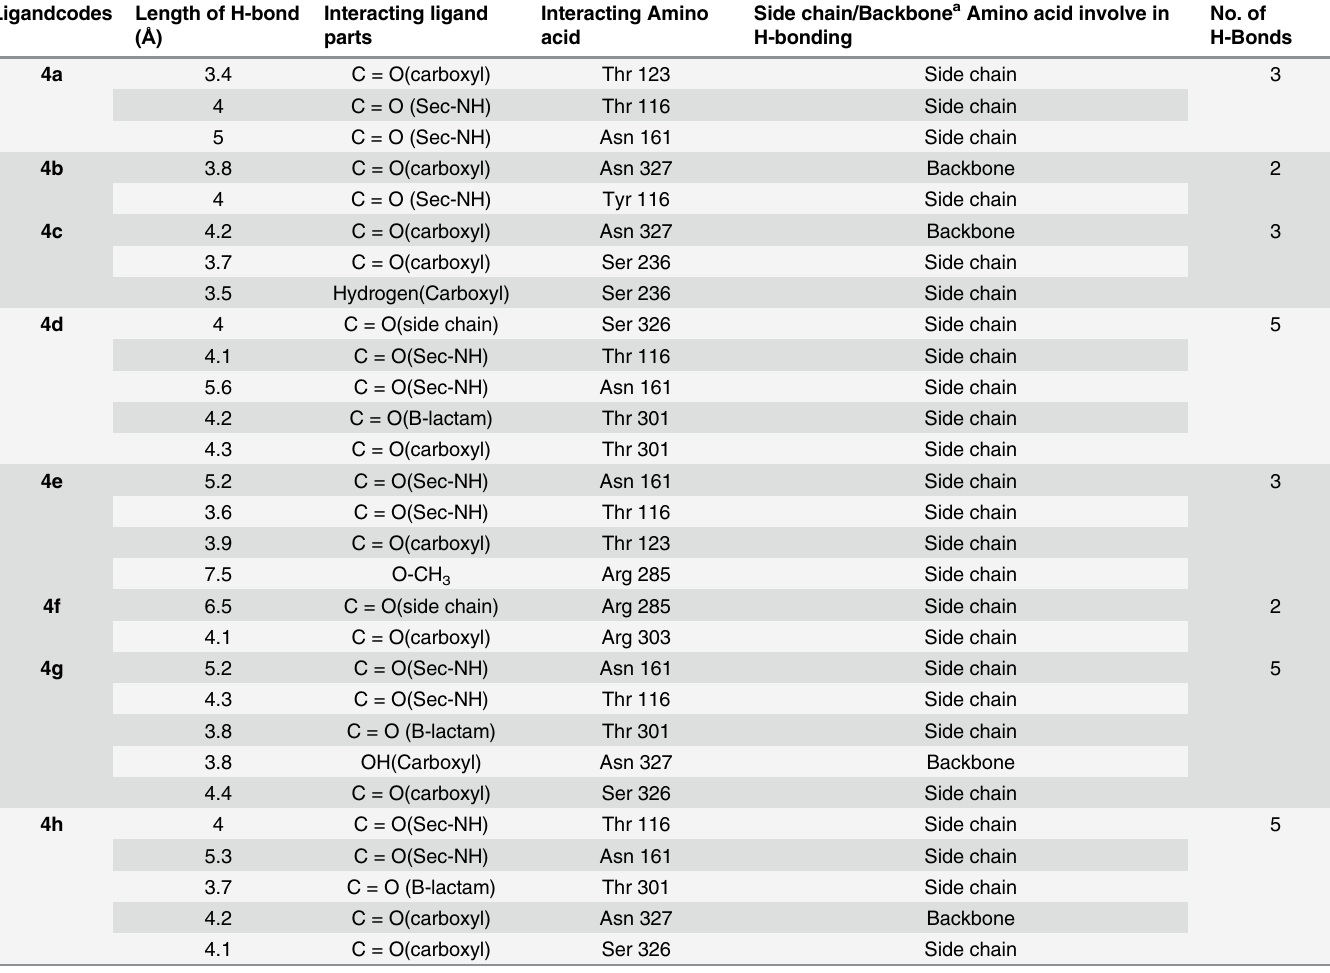
Table 2. Hydrogen bonding between penicillin derivatives (4a-h) and receptor. Ligandcodes Length of H-bond ( Å